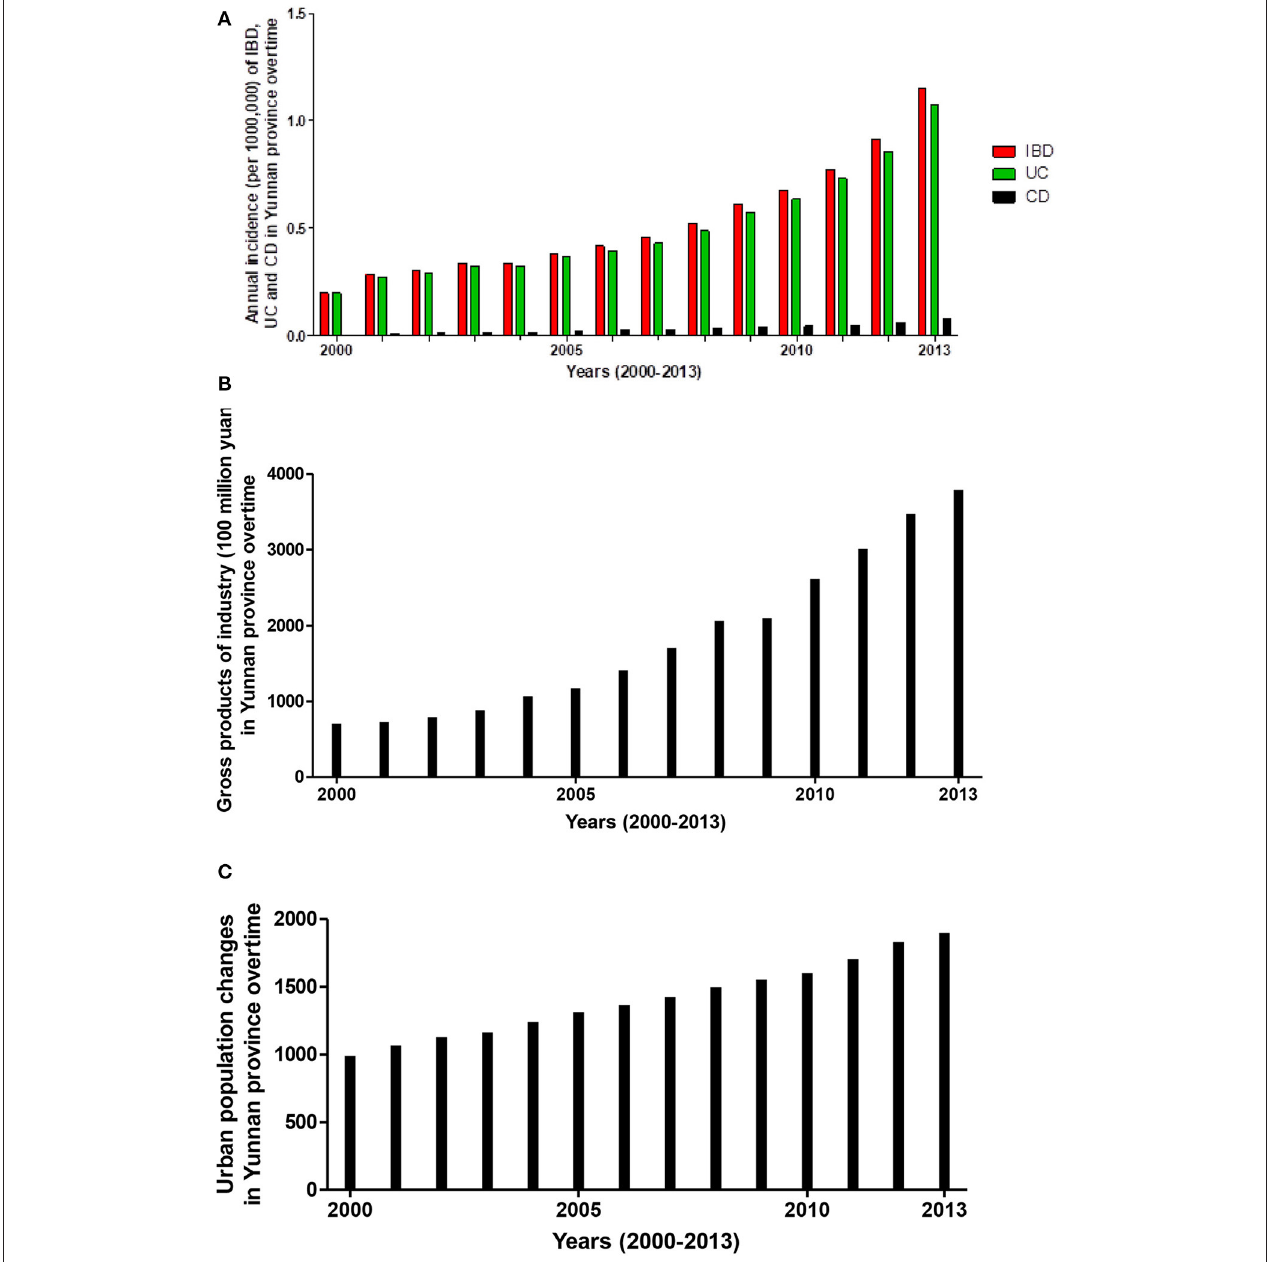
FIGURE 2 | Increasing incidence trends of IBD, UC and CD showed a similar trend of gross products of industry in Yunnan Province over a 14-year interval (2000–2013). Statistical data showed that increasing incidences (/1,000,000) of IBD, UC and CD (A) paralleled the increasing gross products of industry [excluding construction (B) ] and urban population [data source from the Yunnan Provincial Bureau of Statistics (C) ] in Yunnan Province over a 14-year interval (2000–2013).